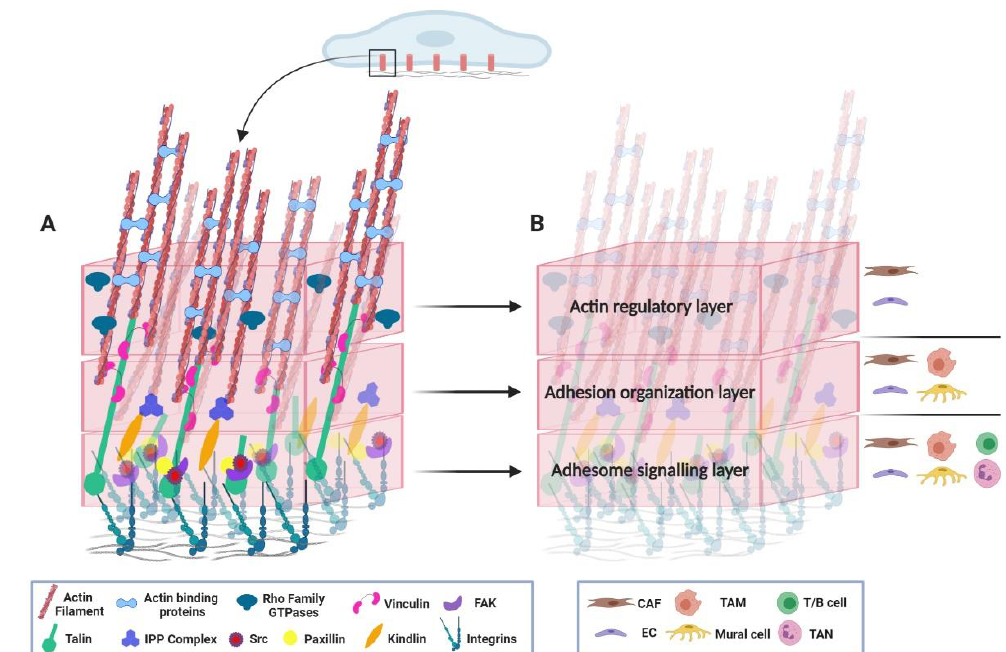
Figure 2. Adhesome in the tumour microenvironment. ( A ) Adhesome molecular architecture. Members of the adhesome, the complex protein network formed at integrin-mediated cell–matrix adhesions (red cylinders at the bottom of the cell), are divided in three levels: the adhesome signalling, the adhesion organisation and the actin regulatory layer (pink boxes). ( B ) Adhesome components and the tumour stroma. The distinct cell types of the TME, with in vivo studied roles of adhesome members are depicted on the right side of each box (layer). Abbreviations: CAF, cancer-associated fibroblast; TAM, tumour-associated macrophage; NK, natural killer; EC, endothelial cell; DC, dendritic cell; TAN, tumour-associated neutrophils; ECM, extracellular matrix.